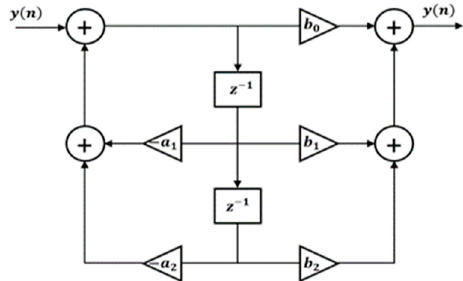
Figure 19. Direct Form II topology used for notch filter implementation.